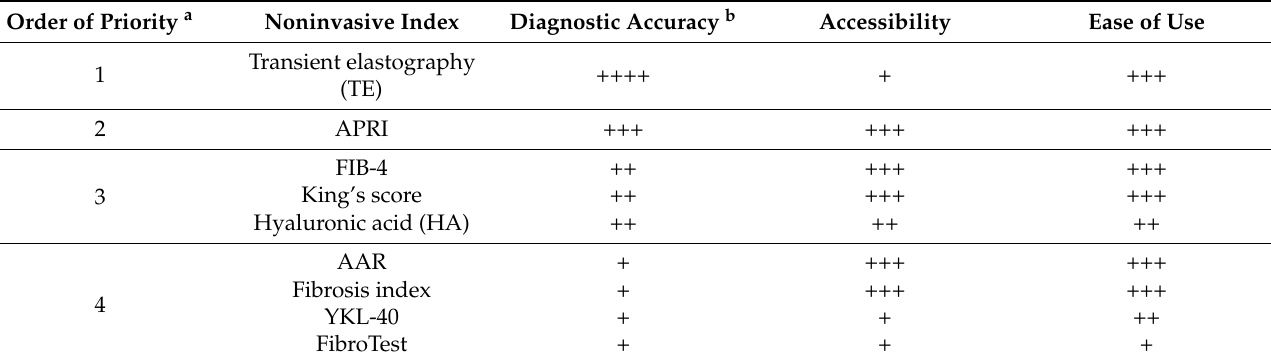
Table 4. Comparison of diagnostic accuracy, accessibility, and ease of use of various noninvasive indices to stage hepatic fibrosis in hemodialysis patients with HCV